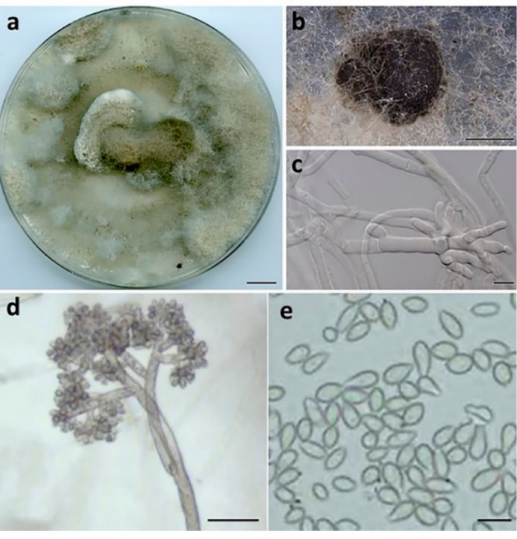
Figure 4. Botrytis macadamiae (BRIP 72295a). ( a ) Two-week-old colony on PDA, ( b ) sclerotia, ( c ) hyphae, ( d ) conidiophore, and ( e ) conidia. Scale bars: ( a ) = 1 cm; ( b ) = 1 mm; ( c , e ) = 10 µ m; ( d ) = 50 µ m.